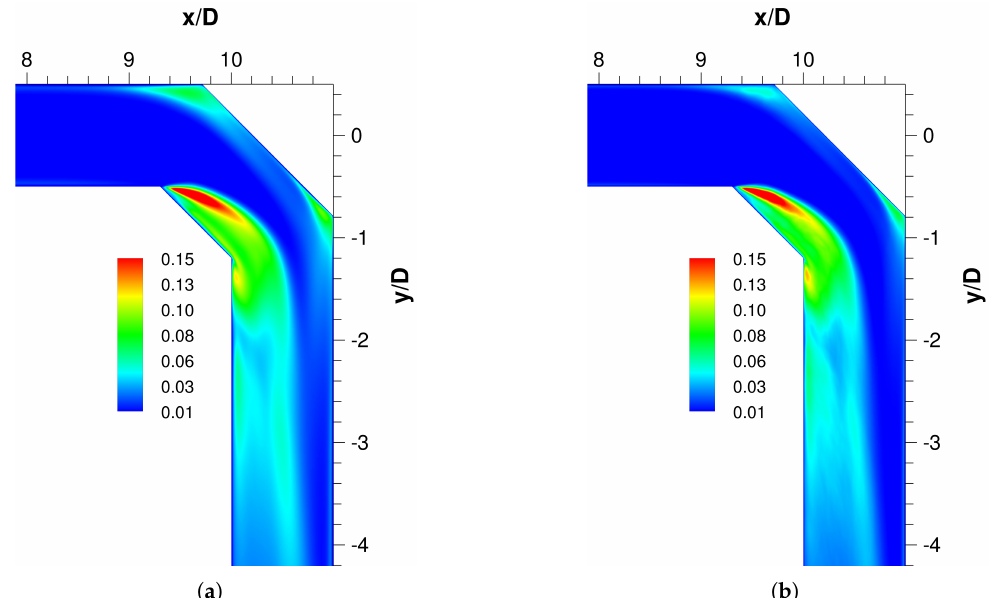
of the 45 ◦ case in the x – y b